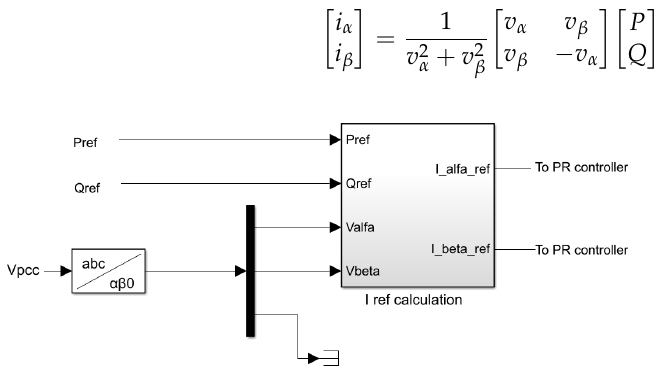
Figure 5. Reference current calculation under balanced PCC